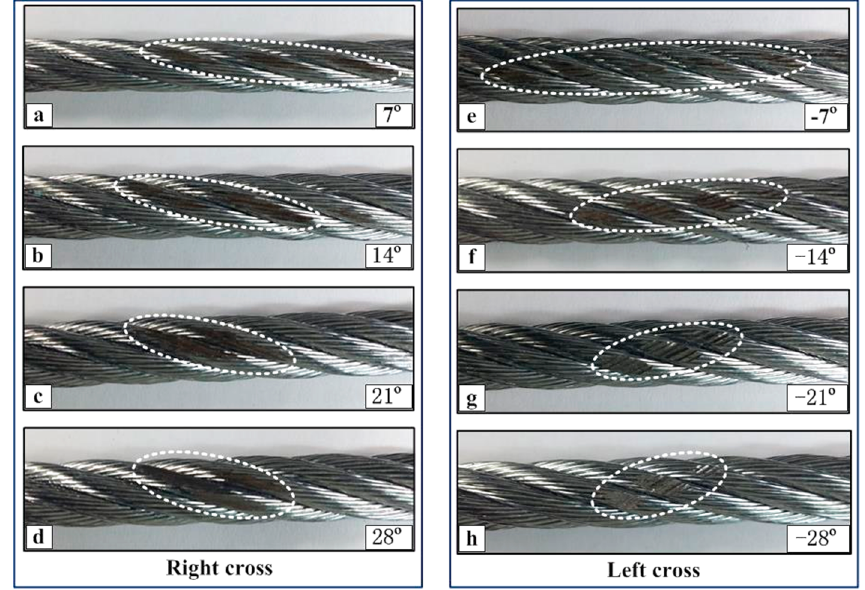
Figure 11. Wear scar pictures of the upper loading rope for a small crossing angle under different sliding conditions ( x : 10 mm; v : 6 mm/s). ( a – d ): Right cross contact; ( e – h ): left cross contact. The wear scar regions are marked by the dashed lines.